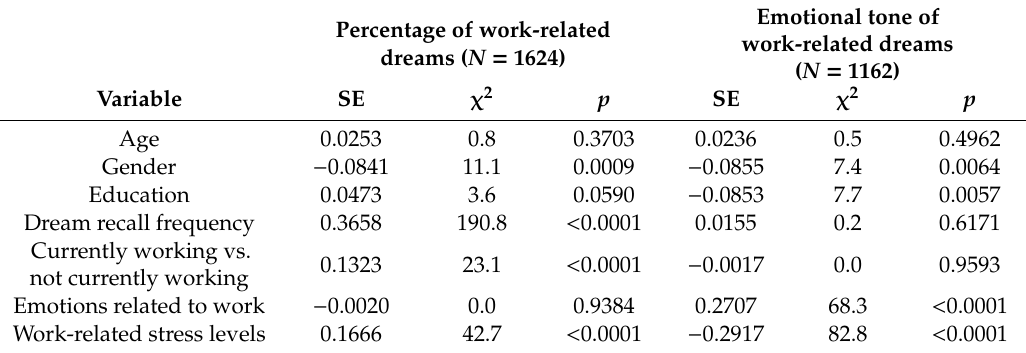
Table 4. Ordinal regression analysis for the categorized (ordinal) percentages of work-related dreams (retrospective estimates) and the overall emotional tone of work-related dreams (total